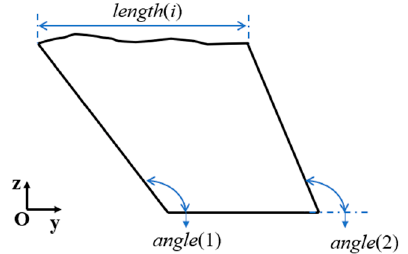
Figure 3. Schematic diagram of cutting parameters. Assuming that the error between the actual weight and the expected weight of each piece is errorW and the error between the diagonal length and the expected length is errorDL , then the score is proportional to errorW and errorDL . The errorW and errorDL of each piece are determined by the actual angle and actual length of the piece. The ultimate goal of this cutting problem is to minimize the score in the cutting